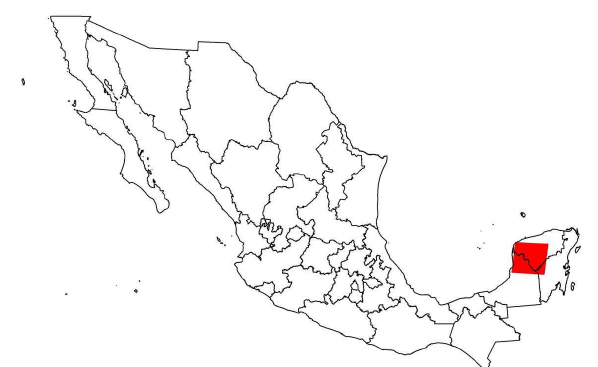
Figure 1. Study areas: the national terrestrial territory of Mexico with its states and location of Landsat path-row 046-020 on the Yucatan peninsula, marked in red.